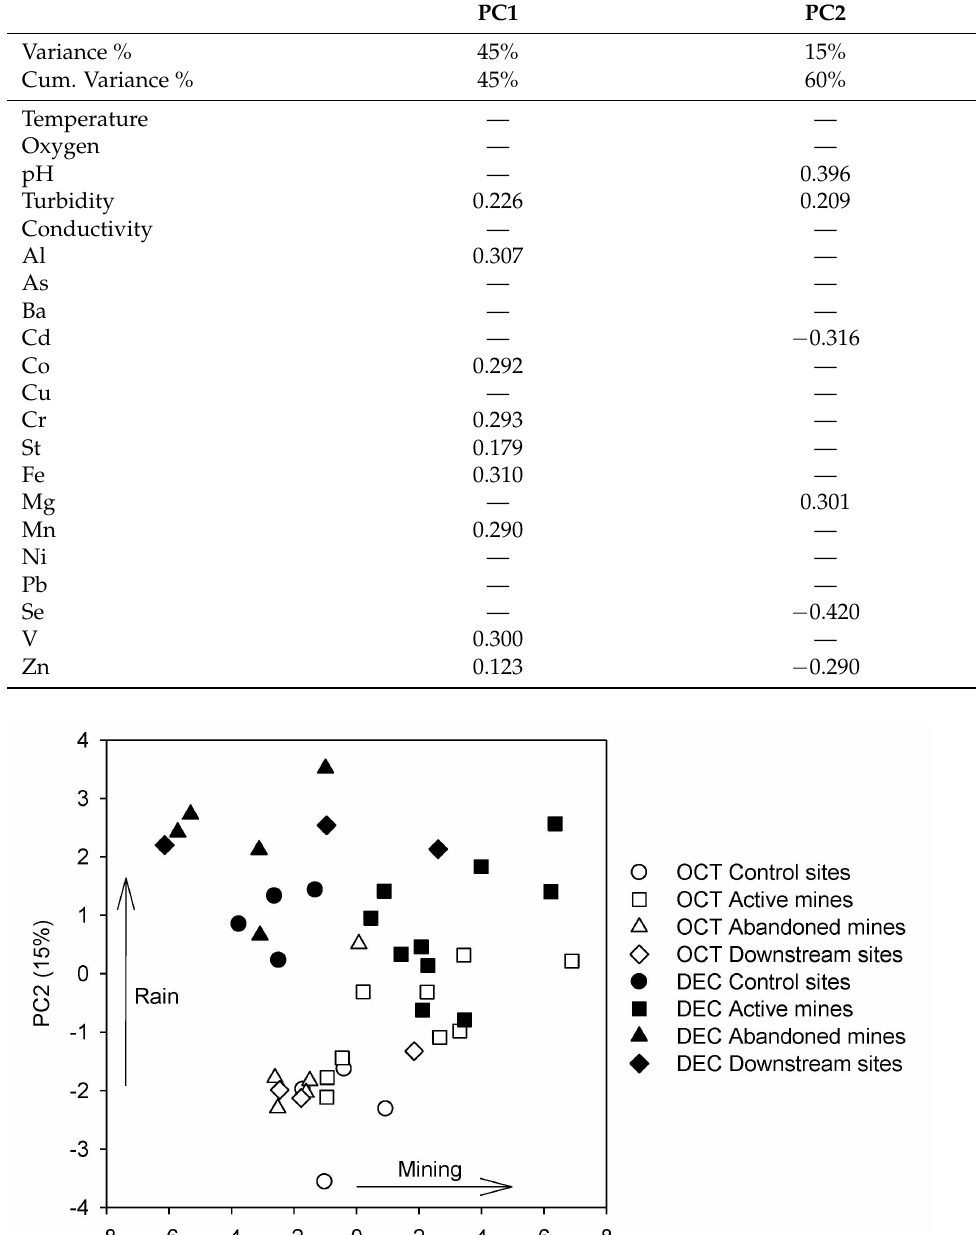
Table 2. Results of the PCA on the physical and chemical variables and heavy metal concentrations. The variance explained by the axes and loadings of variables that were selected by the broken-stick method are listed.